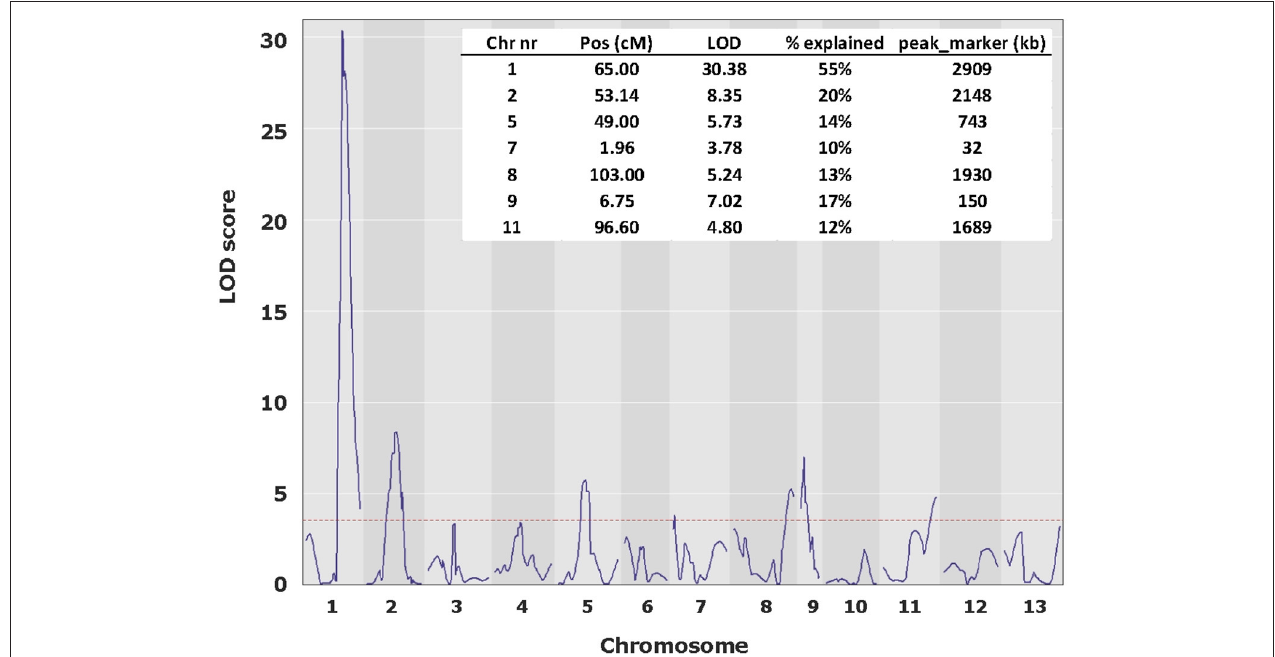
FIGURE 4 | QTL plot for BSN along the 13 chromosomes. The major QTL, Bsn -QTL-1 on chromosome 1 peaks at a LOD value of 30 and Bsn-QTL-2 on chromosome 2 peaks at a LOD value of 8. LOD threshold ( p < 0.05) is 3.52.